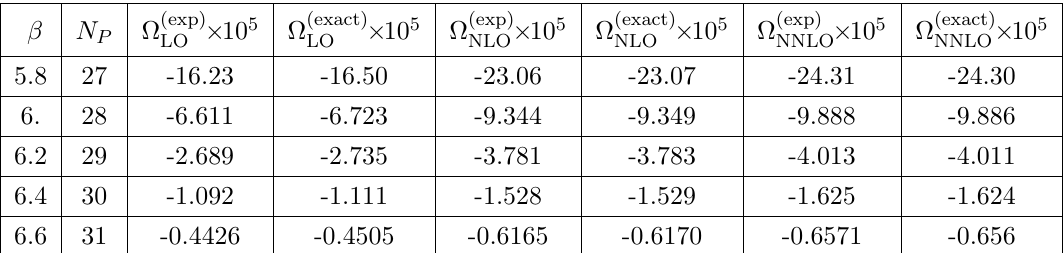
Table 1 . A representative set of values of (cid:10) at di(cid:11)erent order in their respective